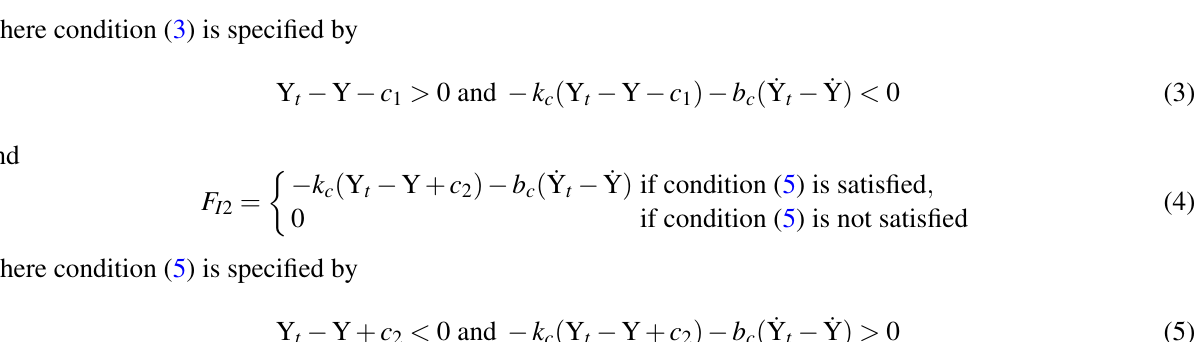
Fig. 2 Vibration of the baseplate given by function